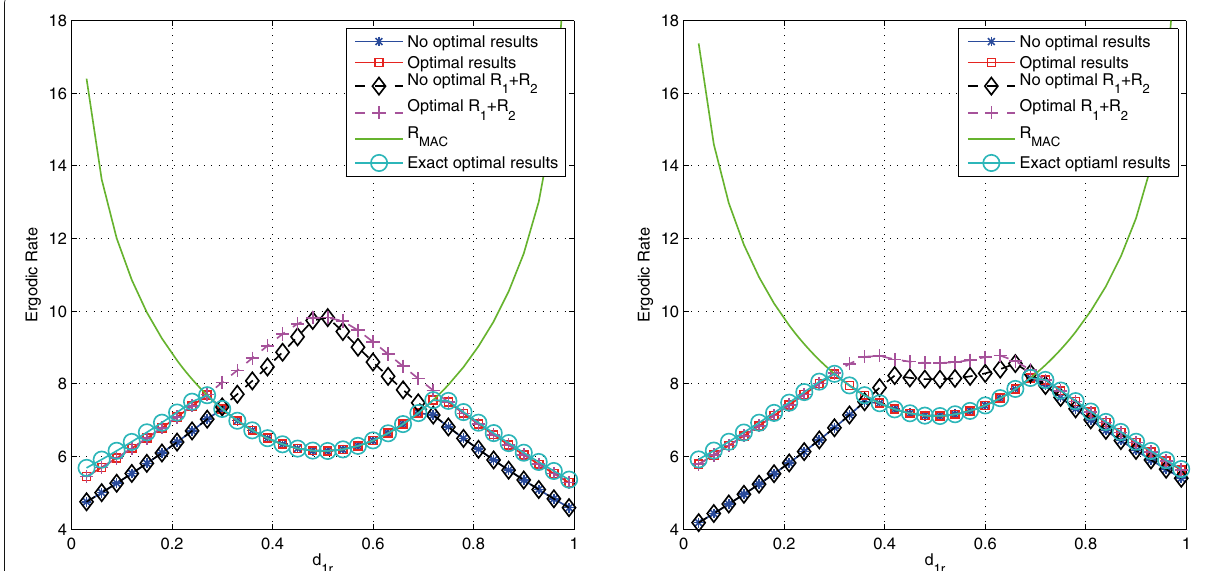
Fig. 7 Ergodic rate performance comparison of the proposed power allocation strategy against different relay node locations and SNRs, including ( d ) = ( 5,5,5 ) , β = 0.5 for the leftsubfigure and ( d b 1 , d b 2 , d cr for